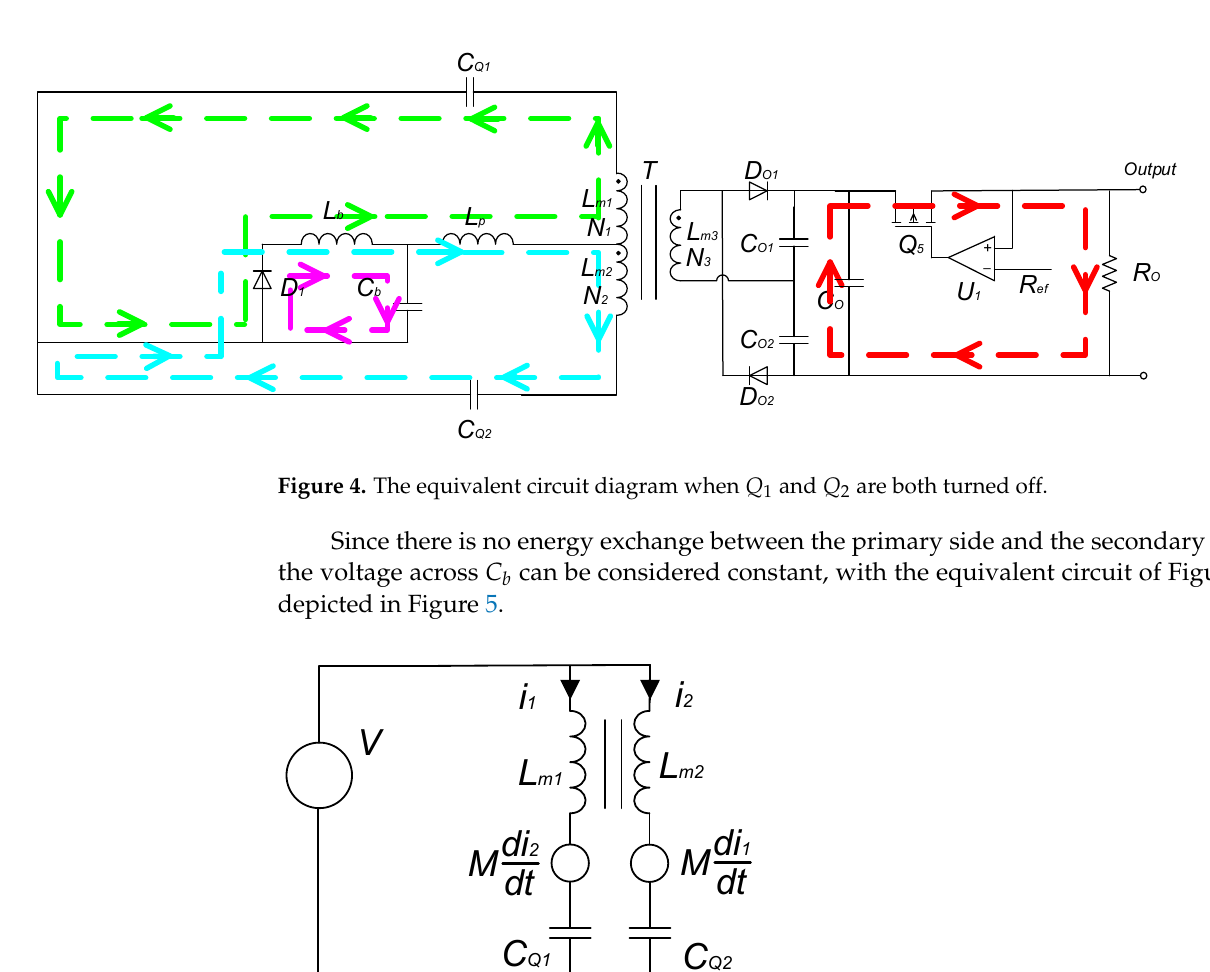
Figure 4. On the primary side, part of the energy in 𝐿 (cid:3029) charges the capacitor 𝐶 (cid:3029) , while the other part flows through 𝐿 (cid:3043) , 𝐿 (cid:3040) , 𝐶 (cid:3018)(cid:2869) , 𝐶 (cid:3018)(cid:2870) , and 𝐷 (cid:2869) sequentially, and then returns to 𝐿 (cid:3029) . On the secondary side, the current flows through There is no energy exchange between the primary side and the secondary side. In Figure 4, the green, blue, and purple arrows indicate the direction of current flow on the primary side, the red arrows indicate the direction of current flow on the secondary side.